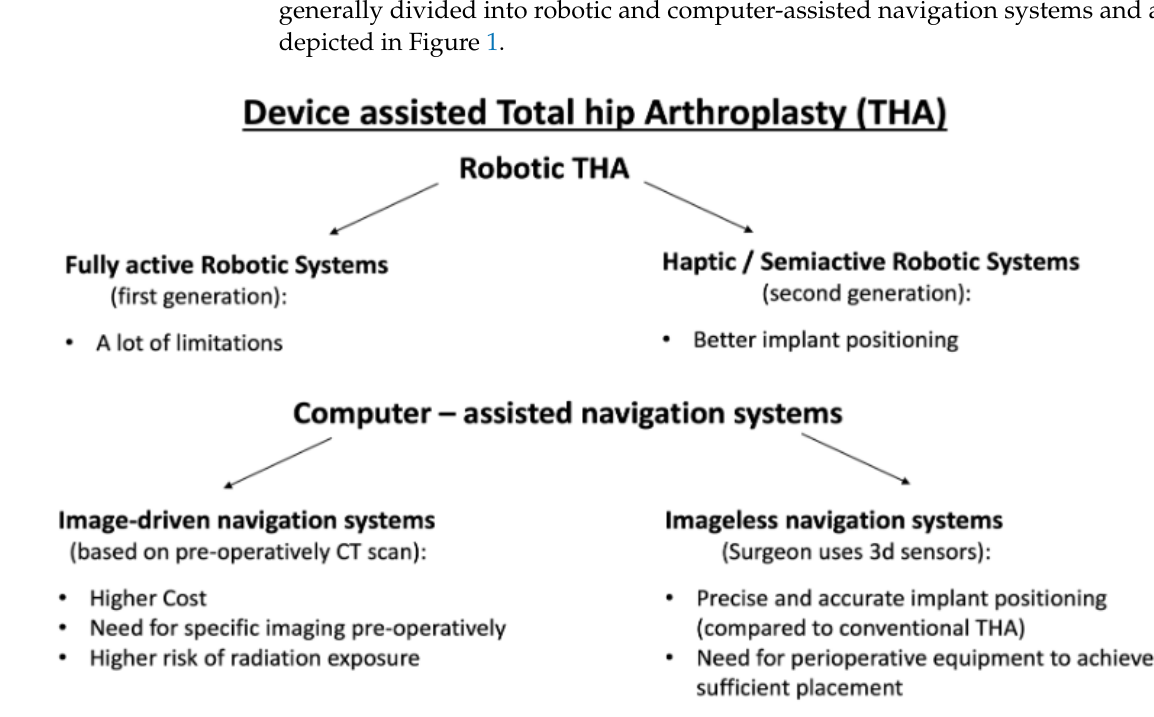
Figure 1. A summary of the major benefits and drawbacks of contemporary technologies used in THA.